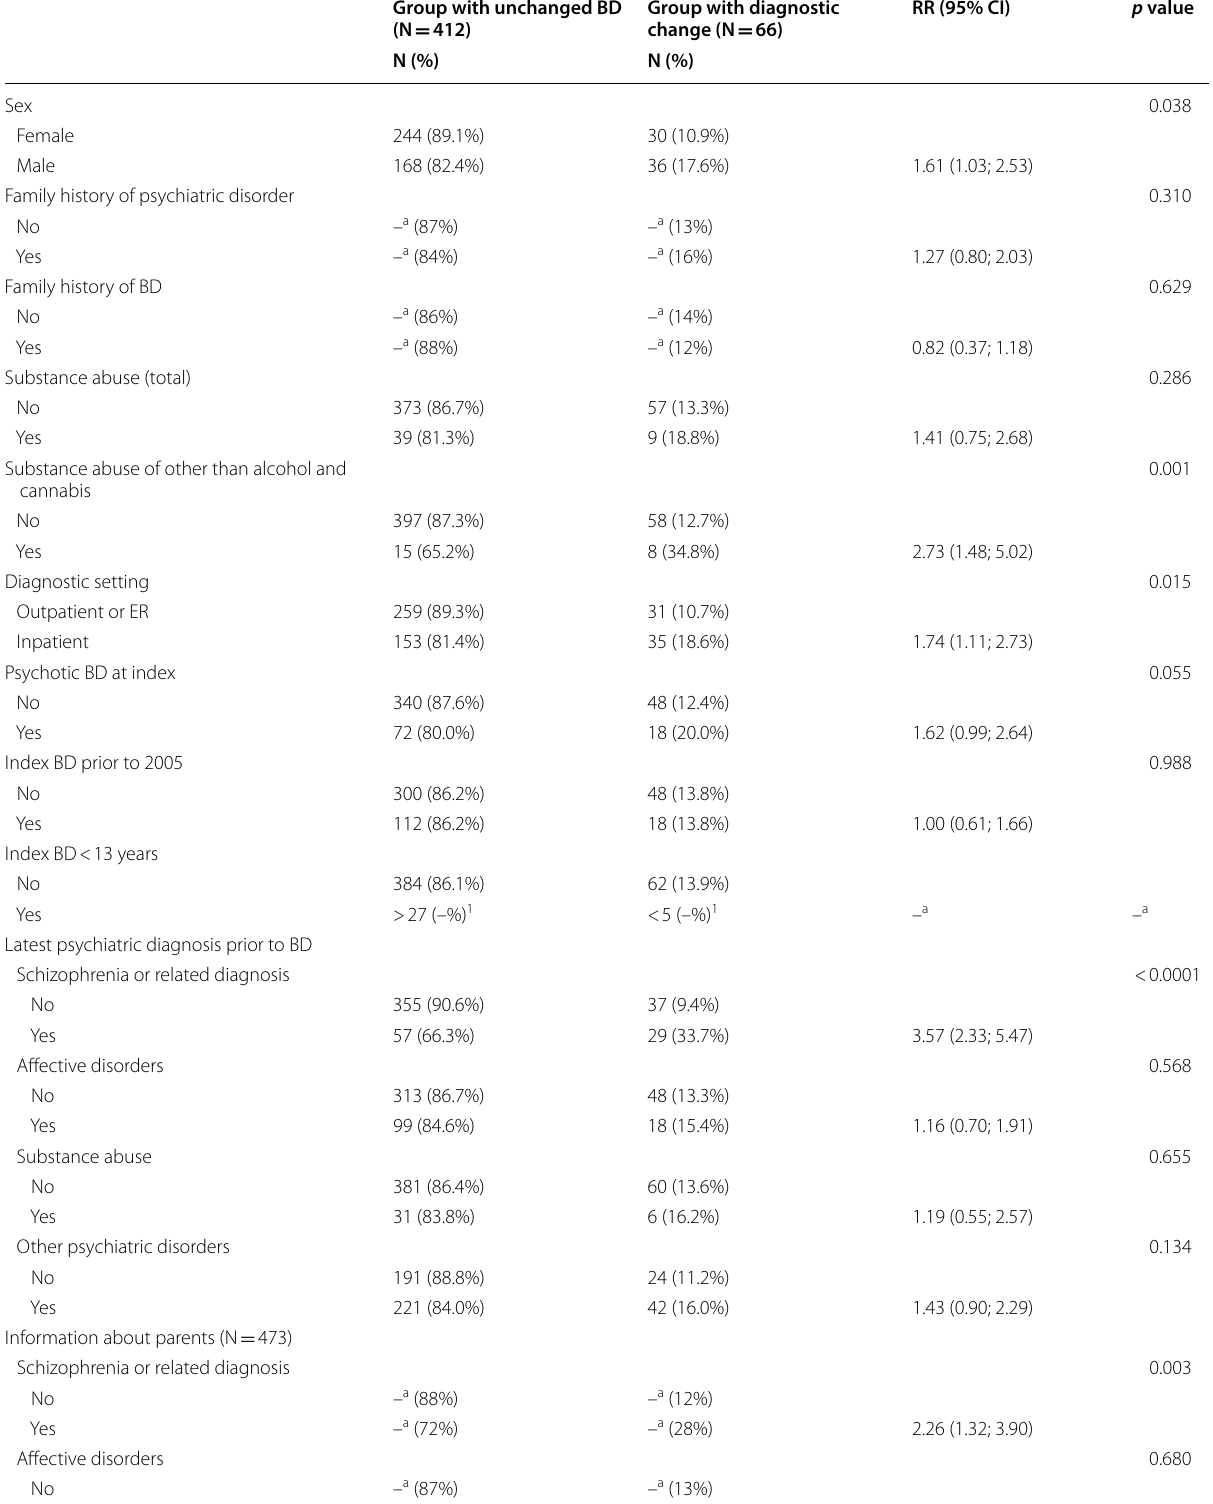
Table 2 Bipolar disorder (BD) in children and adolescents with and without diagnostic change after 3 years of follow-up (N =